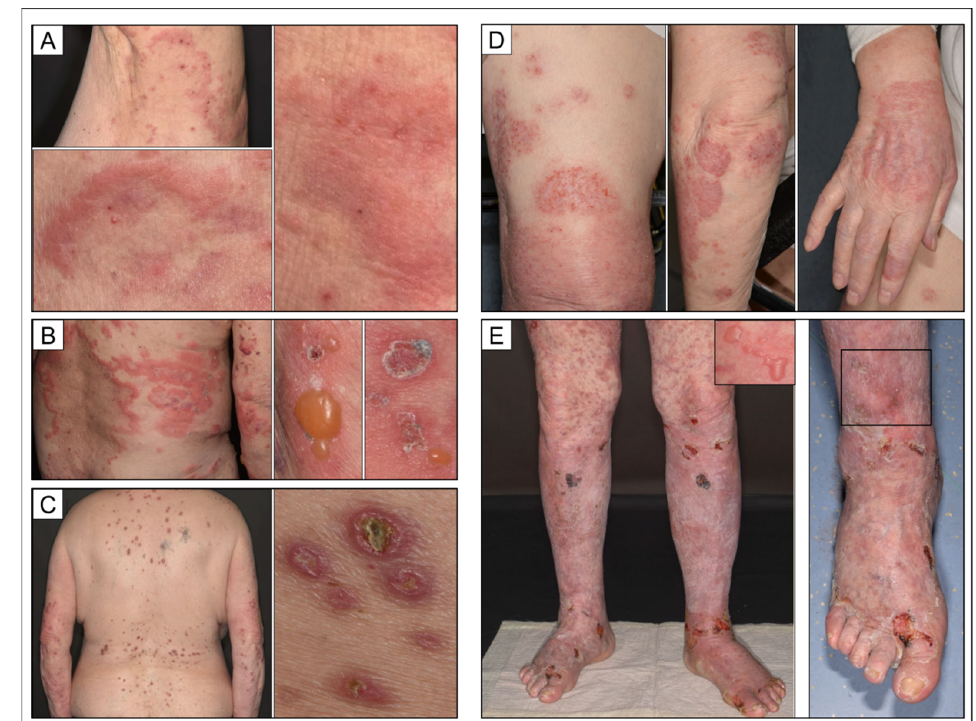
Figure 1. Clinical synopsis of different manifestations of bullous pemphigoid. ( A ) Prodromal stage of bullous pemphigoid featuring urticarial plaques without blistering. ( B ) Fully developed typical bullous pemphigoid featuring more livid erythematous urticarial plaques with tense blisters in the peripheral rim; older lesions exhibit crusts. ( C ) Clinical variant of bullous pemphigoid showing features of chronic prurigo while lacking vesicles; singular lesions display an umbilicated aspect and are restricted to areas amenable to persistent rubbing. ( D ) Bullous pemphigoid in a psoriatic patient; distinct eczematous clinical picture restricted to preexisting psoriatic plaques. ( E ) Acute pustular exacerbation of long-standing papulosquamous psoriasis after psoralen ultraviolet A (PUVA) therapy. Note concomitant tense blisters and pustules in different areas (rectangles).